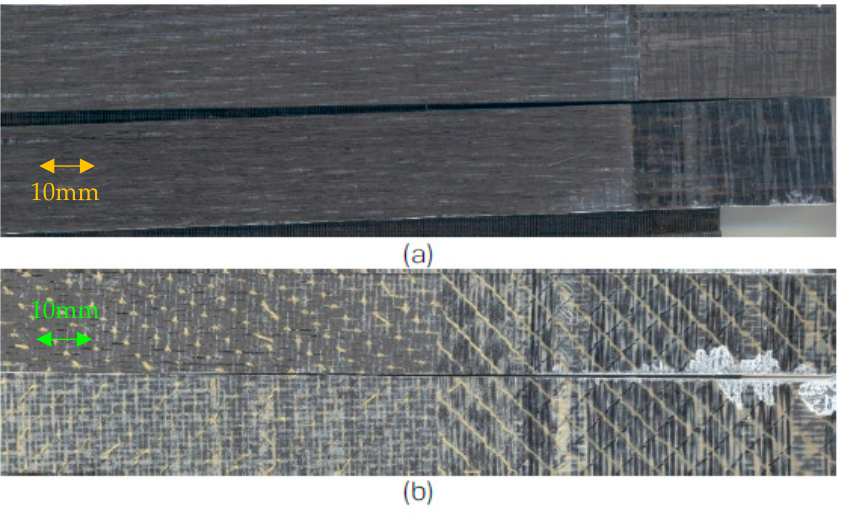
Figure 10. Mode I failure surfaces of NCF ( a ) T700/PA6.6 and ( b ) T700/PPS; crack growth from right to left.